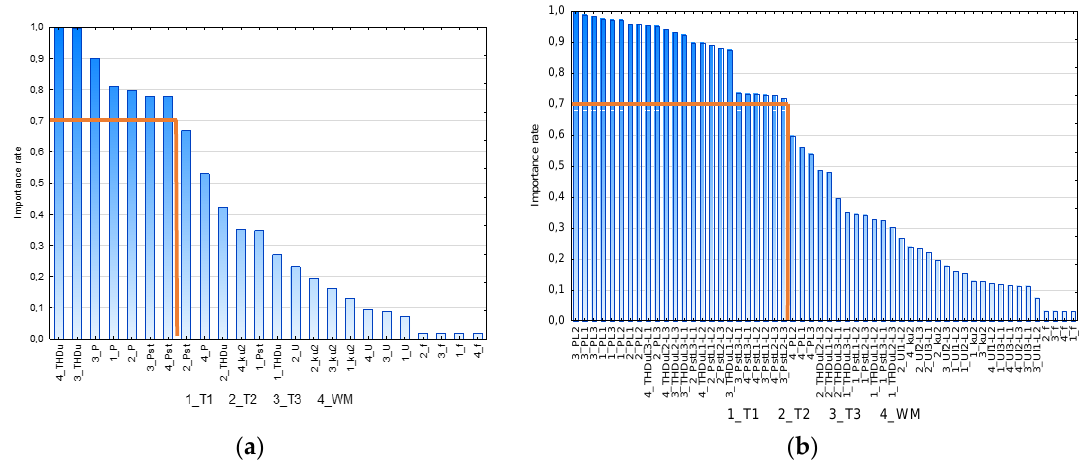
Figure 11. Importance rate for six clusters for ( a ) reduced input database; ( b ) complete input database.